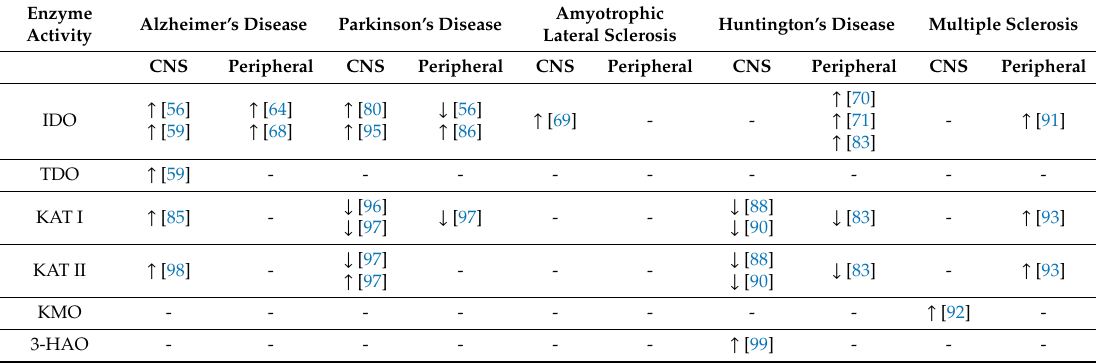
Table 2. Changes of metabolites of the kynurenine pathway in neurologic diseases. ↑ : increase, ↓ :